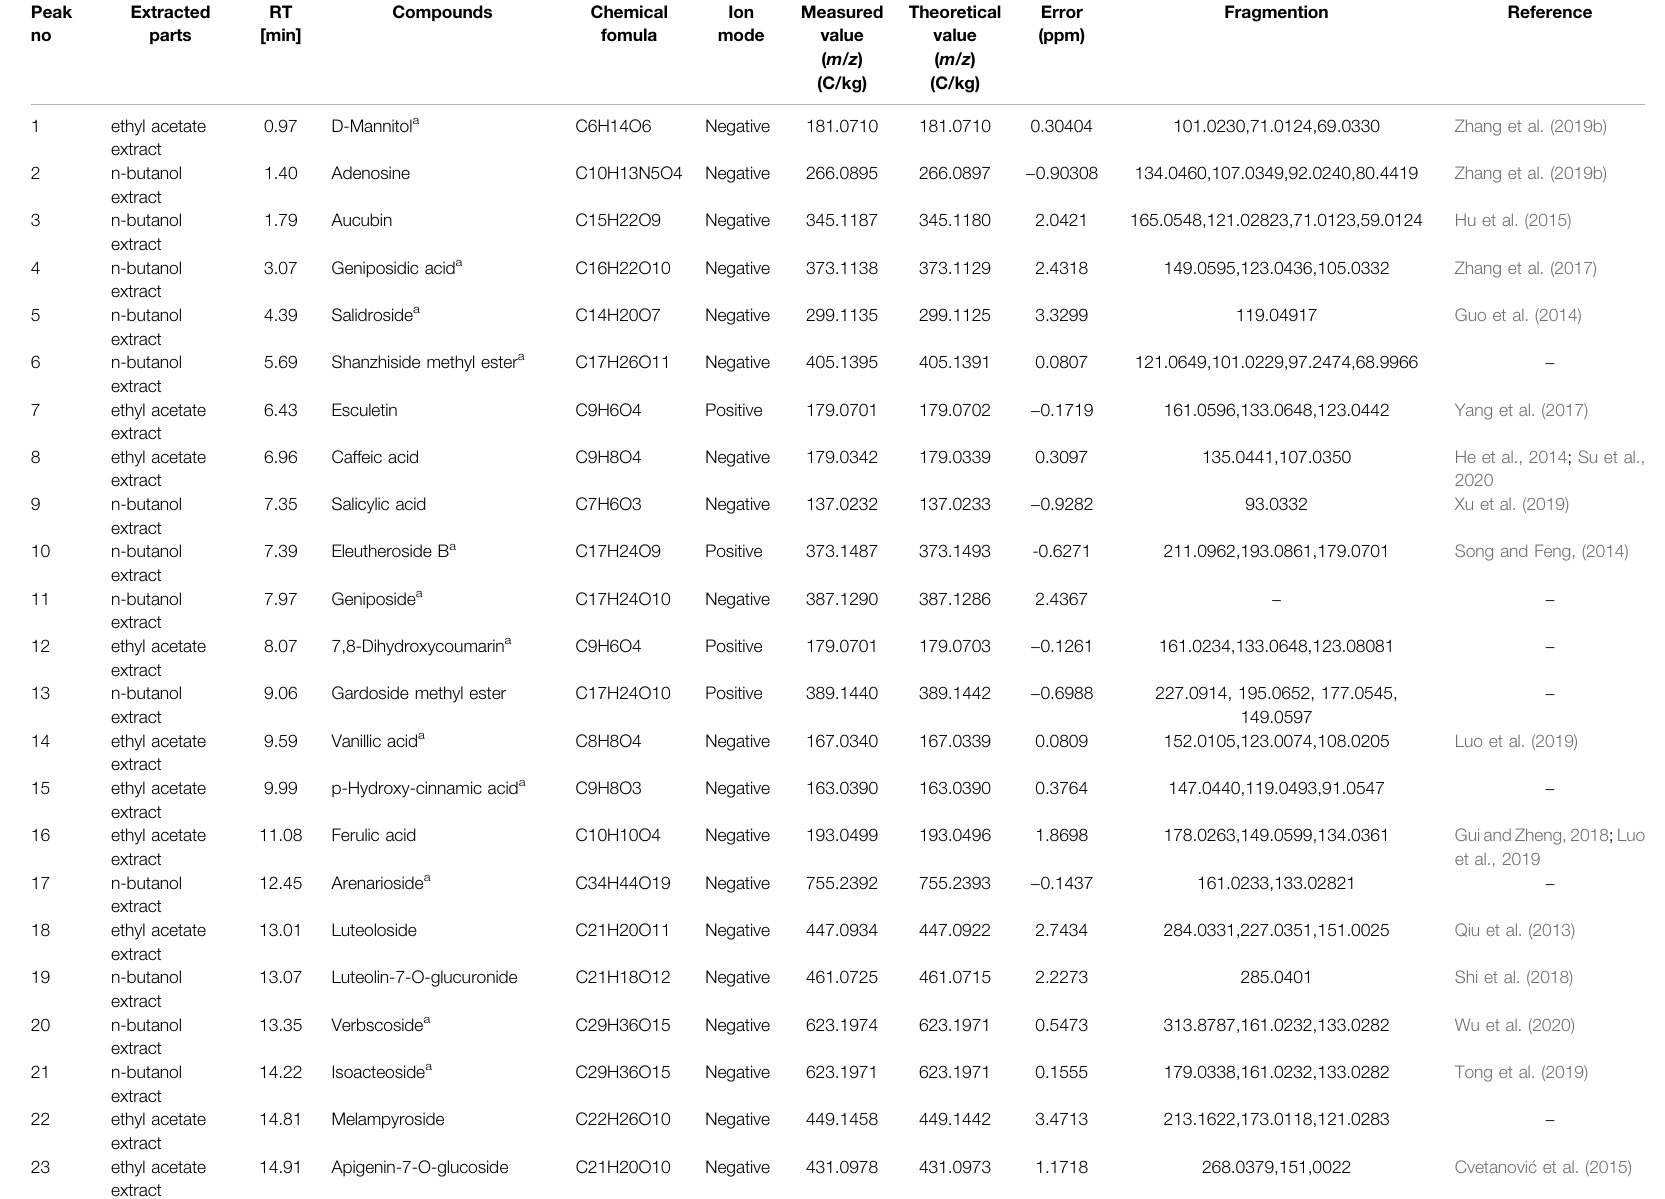
TABLE 1 | Identi fi cation of major chemical compounds in n-butanol extract and ethyl acetate extract form the O. vulgaris